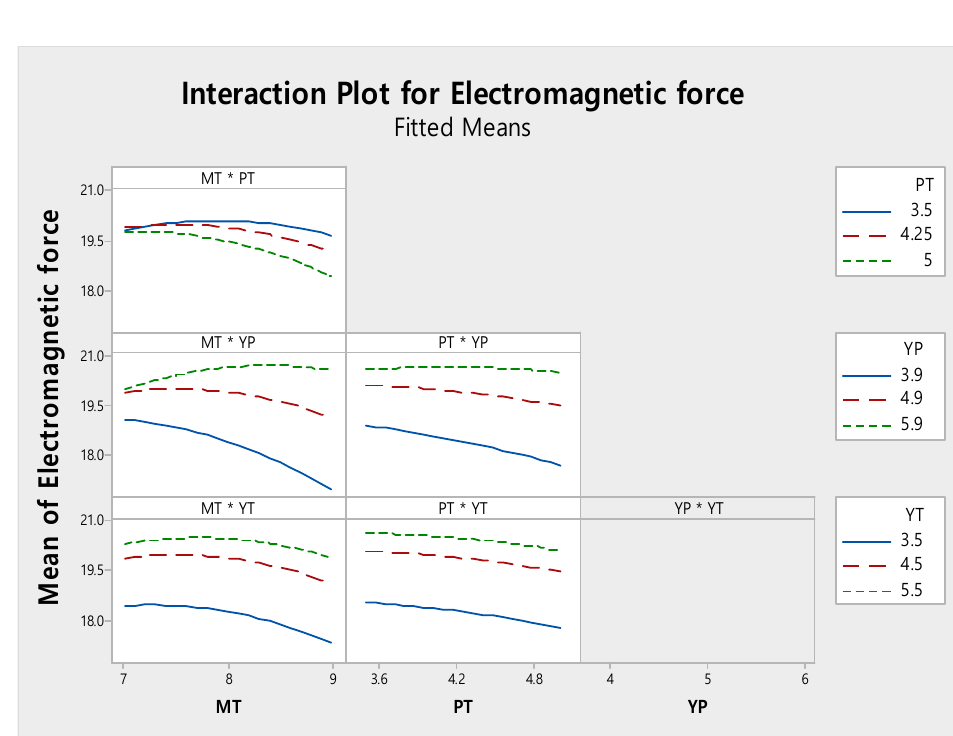
Figure 7. Main effects plot for electromagnetic force.